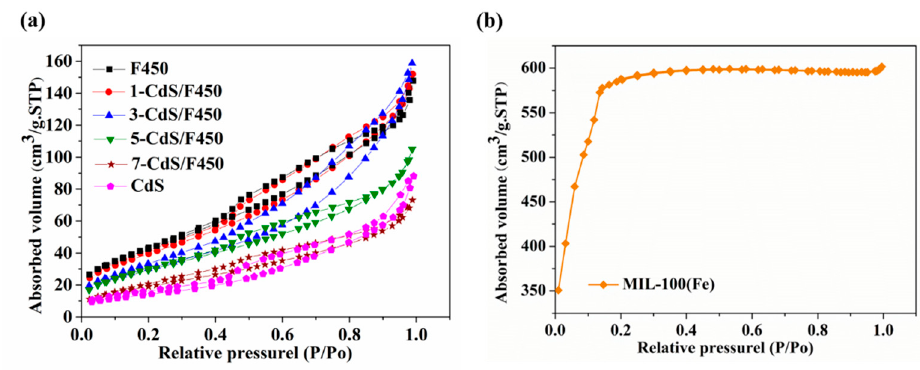
Figure 5. Nitrogen adsorption isotherms of ( a ) F450, CdS and X–CdS / F450, ( b ) MIL-100(Fe). Table 2. The BET surface area and pore volume of F450, CdS, MIL-100(Fe) and X–CdS/F450 nanocomposites.